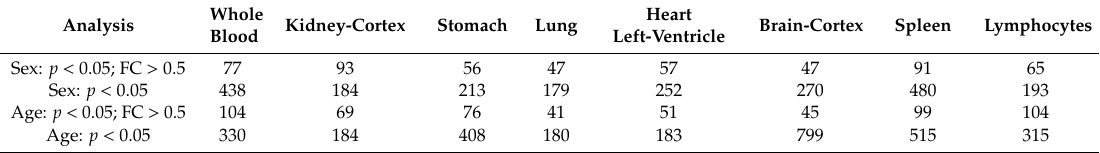
Table 1. Number of di ff erentially expressed COVID-19 Disease Map genes and COVID-19 related pathways genes between sex and age groups in di ff erent human tissues and cell types. The number of significant ( p -value ( p ) < 0.05) genes are reported either with or without a fold-change (FC) cuto ff value of